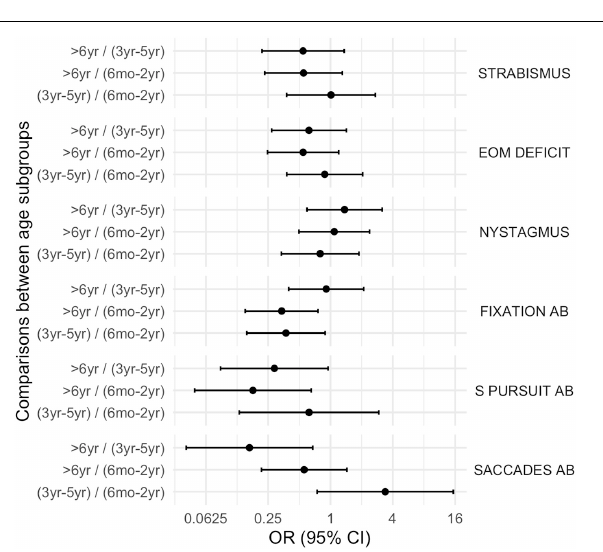
FIGURE 5 | Comparison between subgroups, OR (CI 95%): oculomotor disorders. EOM deficit, extrinsic ocular motility deficit, Ab, abnormalities, S. Pursuit, smooth